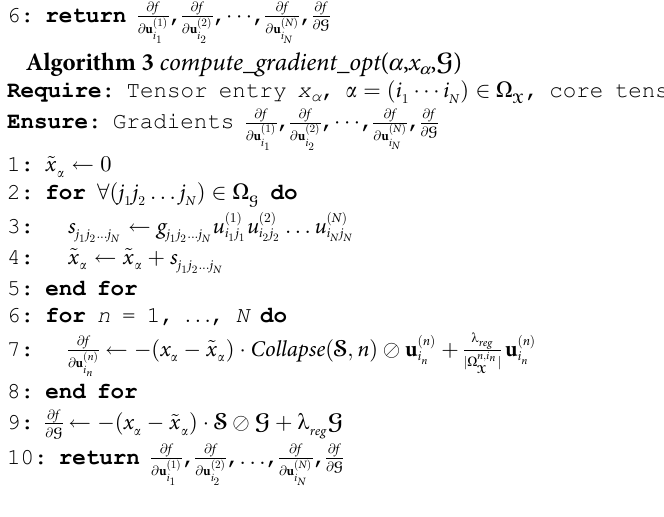
Algorithm 3 compute_gradient_opt ( α , x